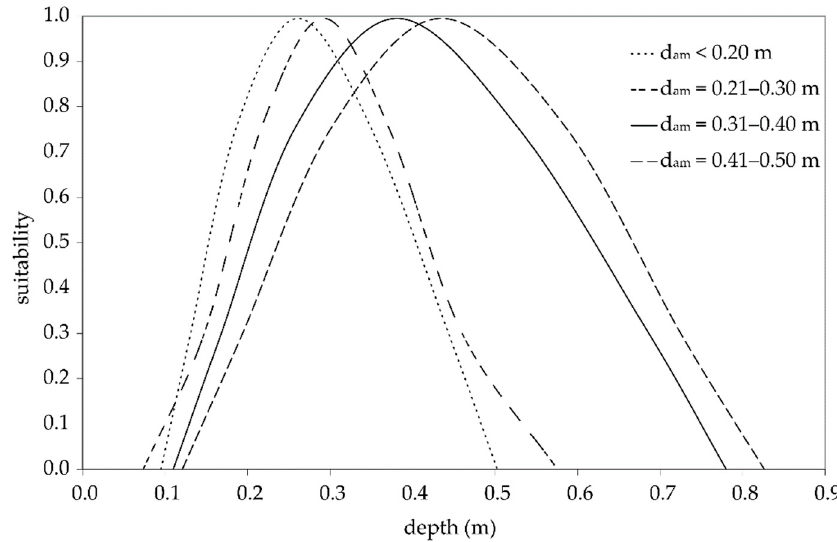
Figure 2. Average depth habitat suitability curves (HSCs) for the brown trout divided by the intervals of the average maximum depth [25].